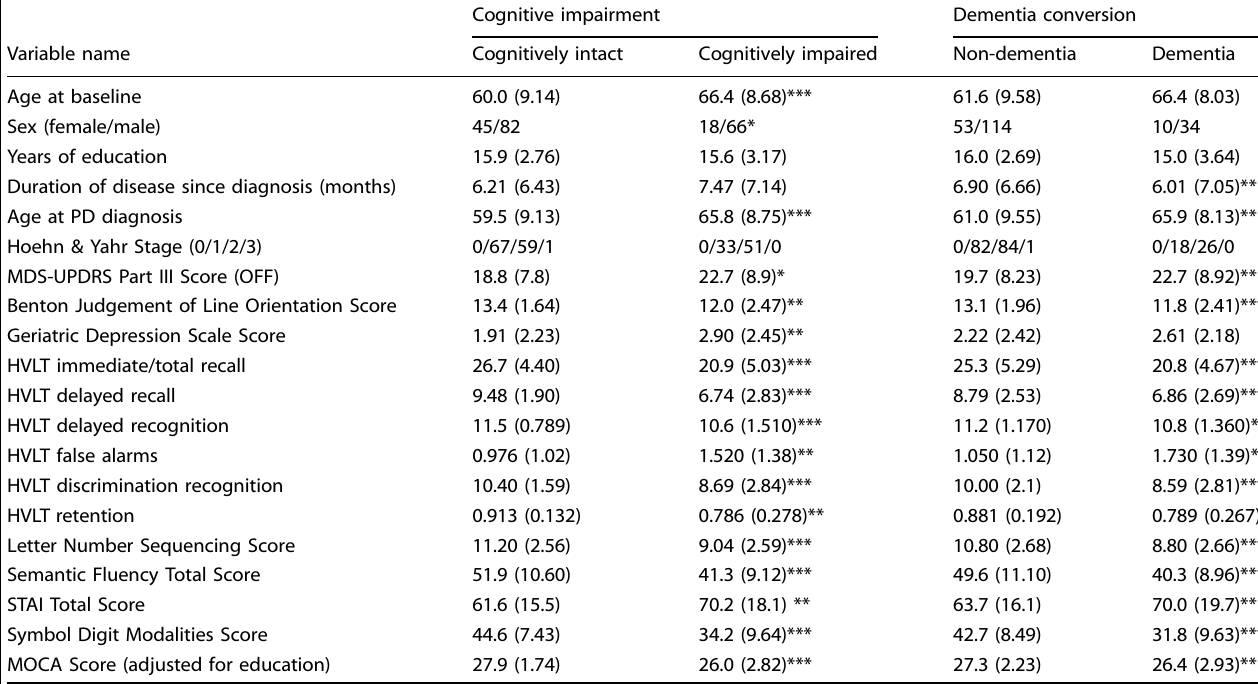
Table 1. Summary statistics of demographic and selected clinical